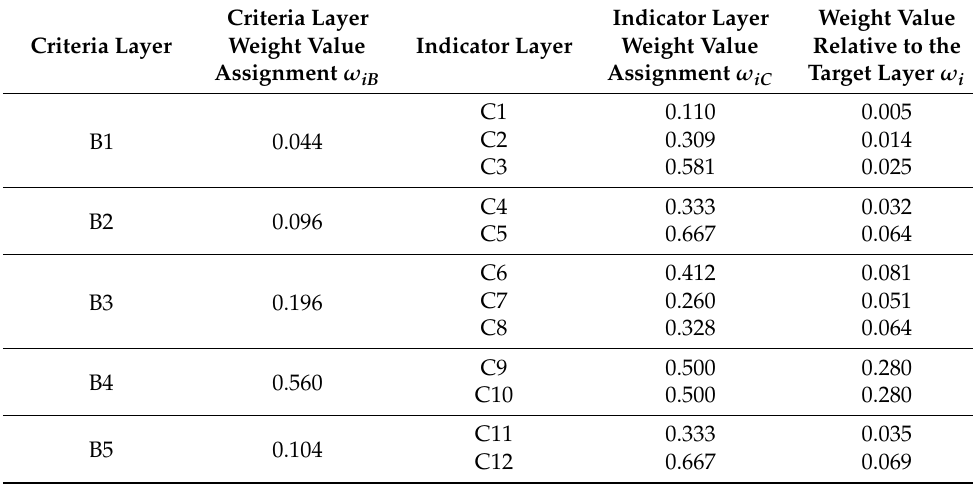
Table 7. Summary table of weight